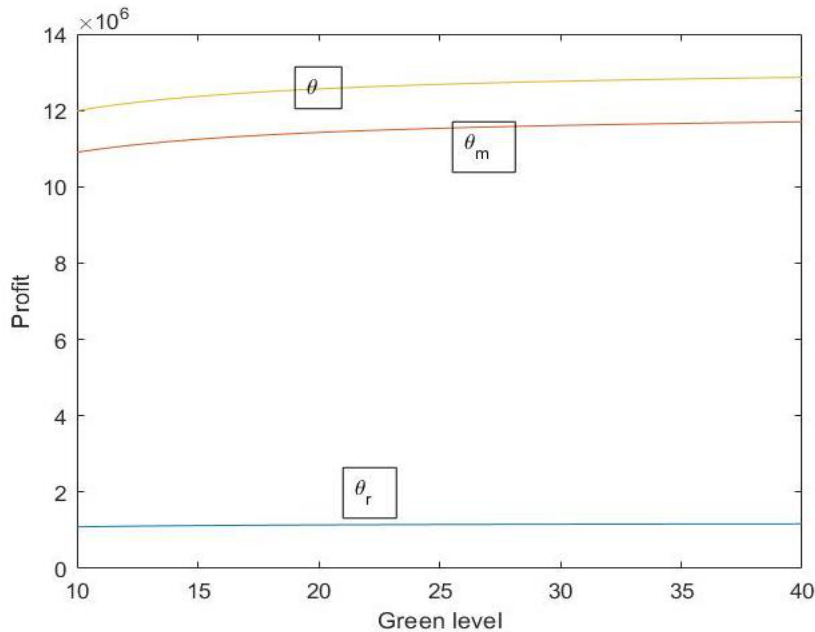
Figure 6. Graphical representation of changes of profit with online